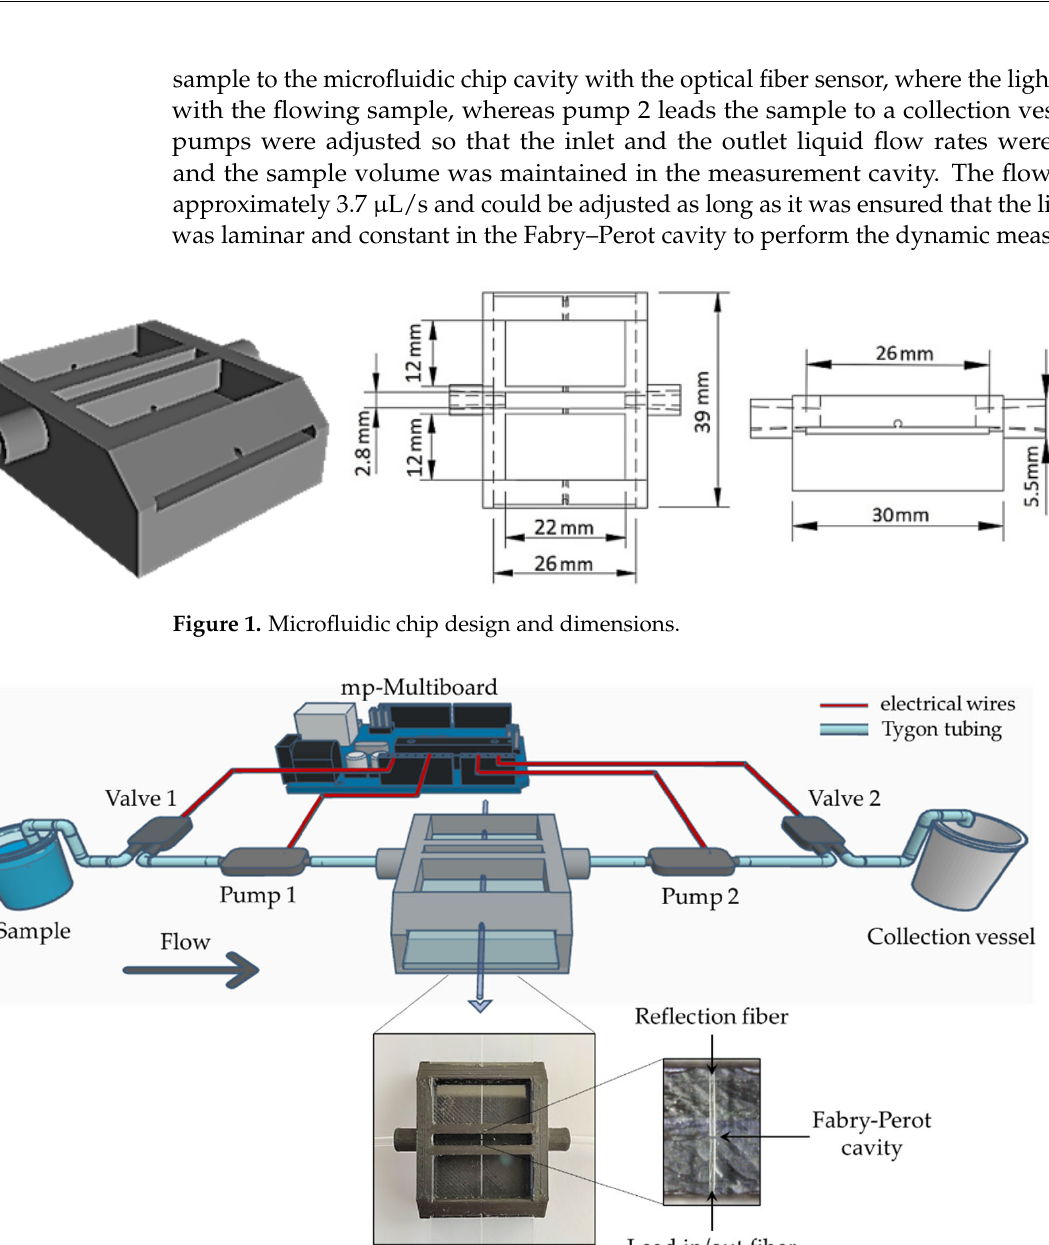
Figure 2. Experimental scheme of the optofluidic platform. The inset shows a photograph of the 3D ‐ printed optofluidic fiber sensor.